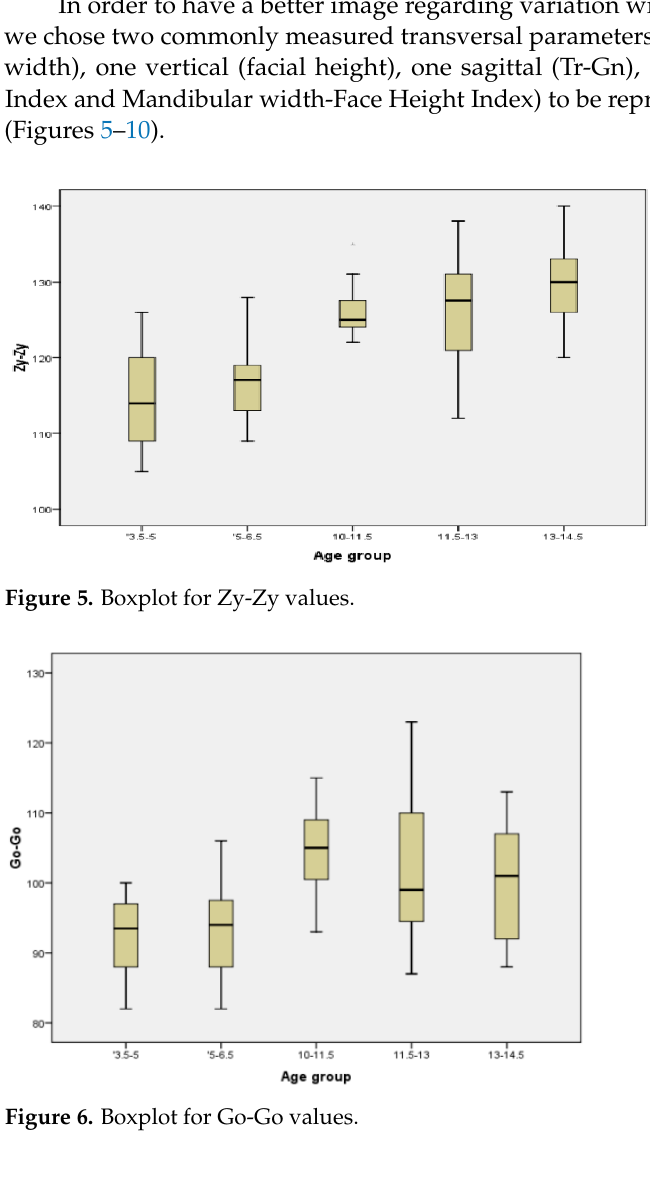
Figure 7. Boxplot for N-Gn values .